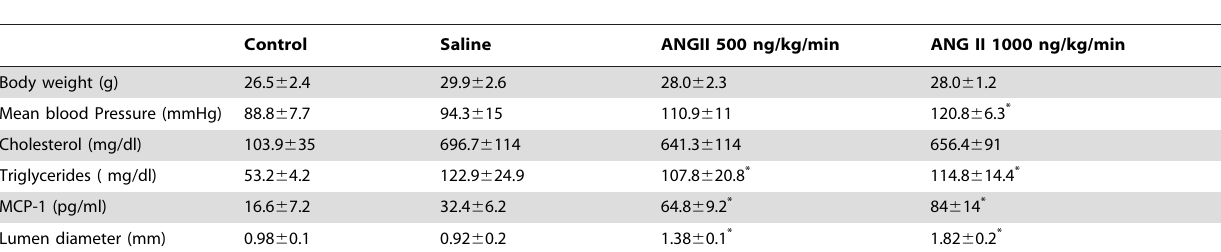
Table 1. Serum lipids and cytokines were measured in apoE 2 / 2 mice after 14 days of Saline or Ang II administration.